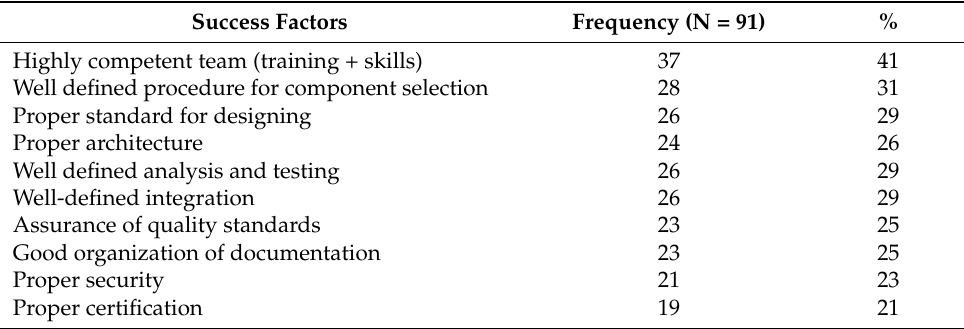
Table 2. Identification of success factors through